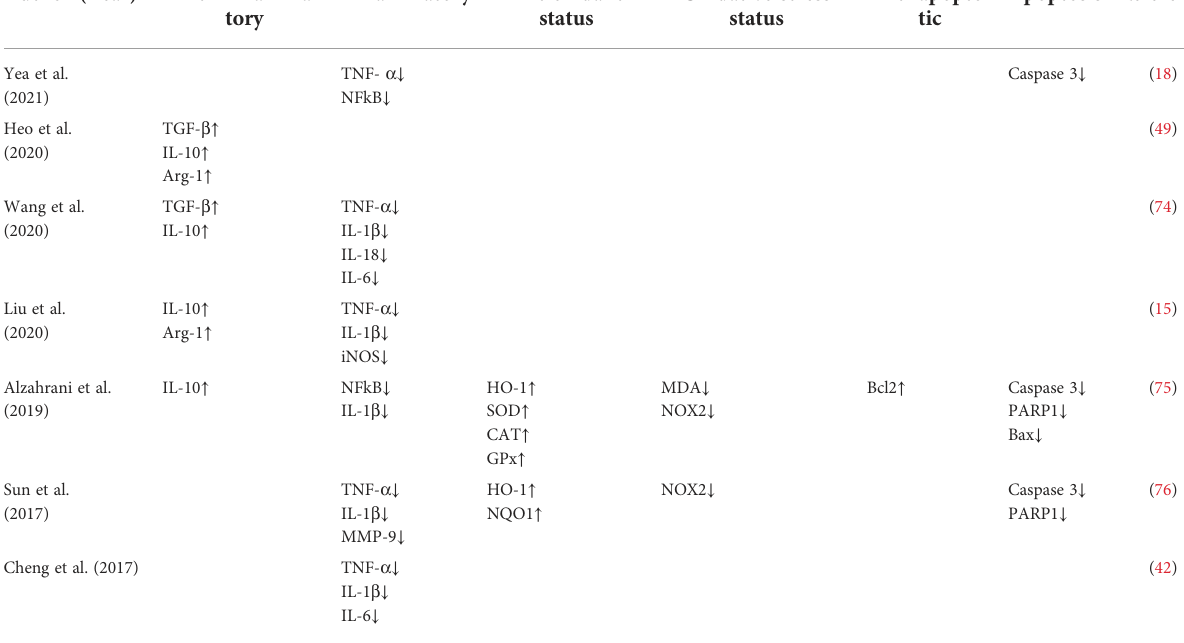
TABLE 3 Expression of in fl ammation, oxidation, and expression of apoptotic factors in